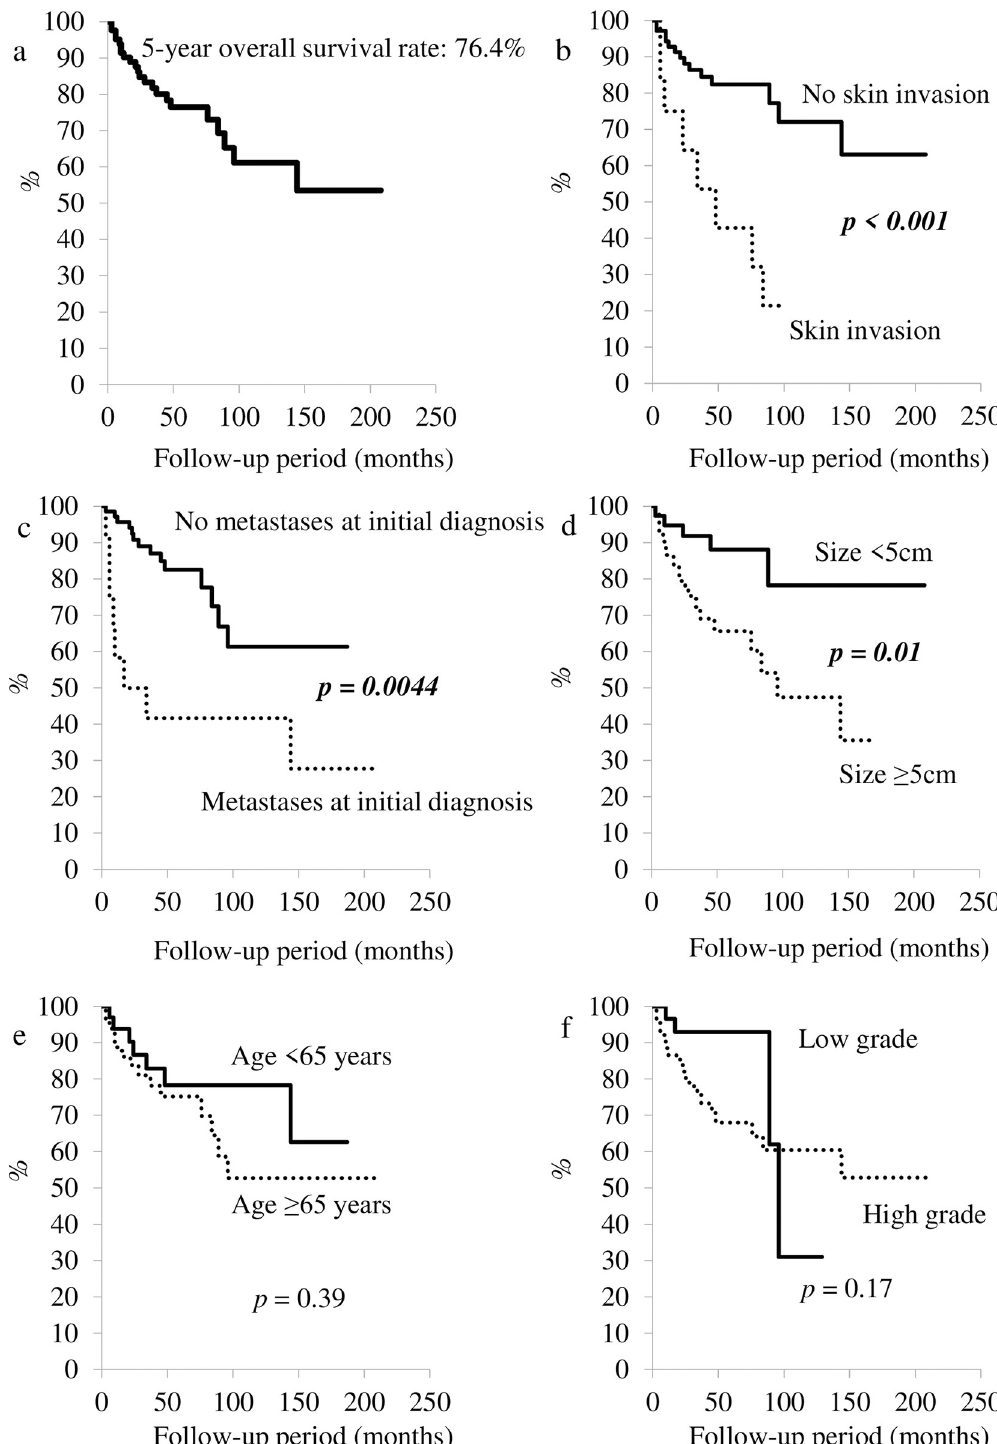
Fig 3. Survival curves. a: Overall survival curve. b: Survival curves for patients with sarcomas invading the skin as well as for patients with sarcomas that did not invade the skin. c: Survival curves for patients with metastases and those without metastases upon initial diagnosis. d: Survival curves for patients with sarcomas measuring < 5 cm and � 5 cm. e: Survival curves for patients aged < 65 and � 65 years. f: Survival curves for patients with high- and low-grade sarcomas.